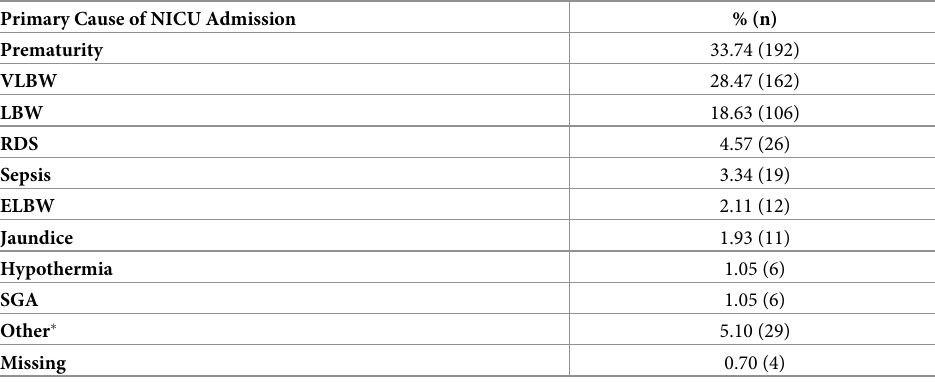
Table 2. Primary cause of NICU admission for neonates (n = 573).